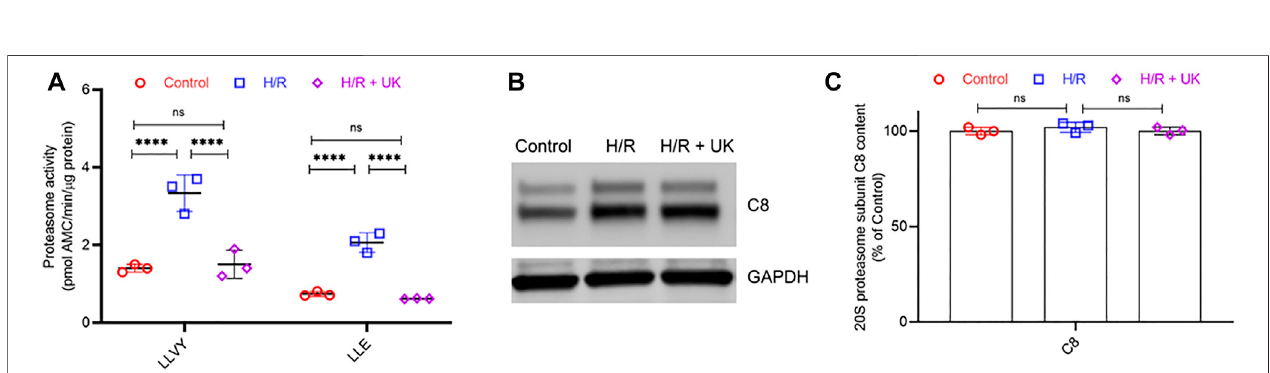
FIGURE 4 | H/R induces global activation of the proteolytic activity of proteasome without induction of proteasome content. (A) Proteasome activity in BEAS-2B cells under control conditions or following H/R ± urokinase (UK). Proteasome activity against fl uorogenic LLE and LLVY substrates was signi fi cantly higher following HR compared to control. Urokinase treatment signi fi cantly decreased the proteolytic activity. Data are represented as mean ± SD; **** p < 0.0001, ns, not signi fi cant ( n = 3). AMC . amido-4-methylcoumarin. (B,C) 20S proteasome subunit C8 protein content in BEAS-2B cells under control conditions or following H/R ± UK. Shown are representative blots (B) and quanti fi cation (C) . Data in C are represented as mean ± SD; ns, not signi fi cant ( n = 3).